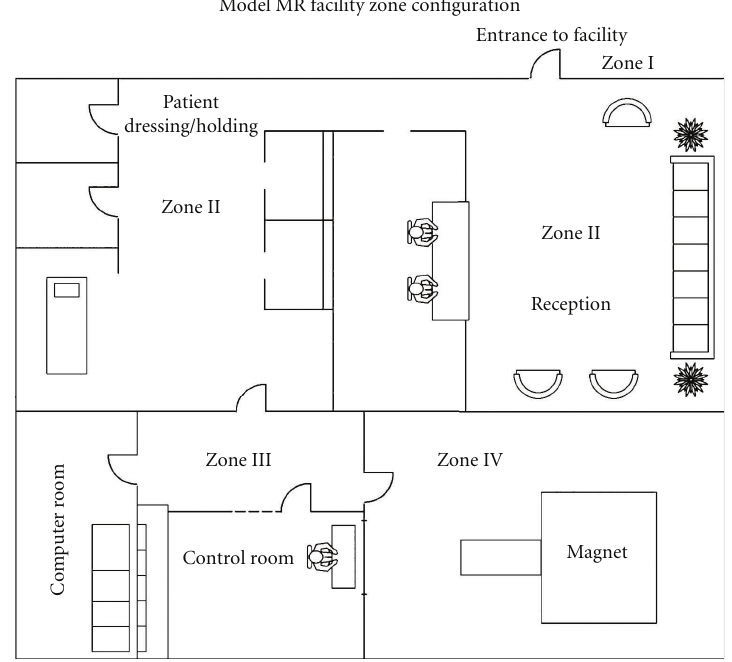
Figure 4: Idealized sample floor plan illustrates site access restriction considerations